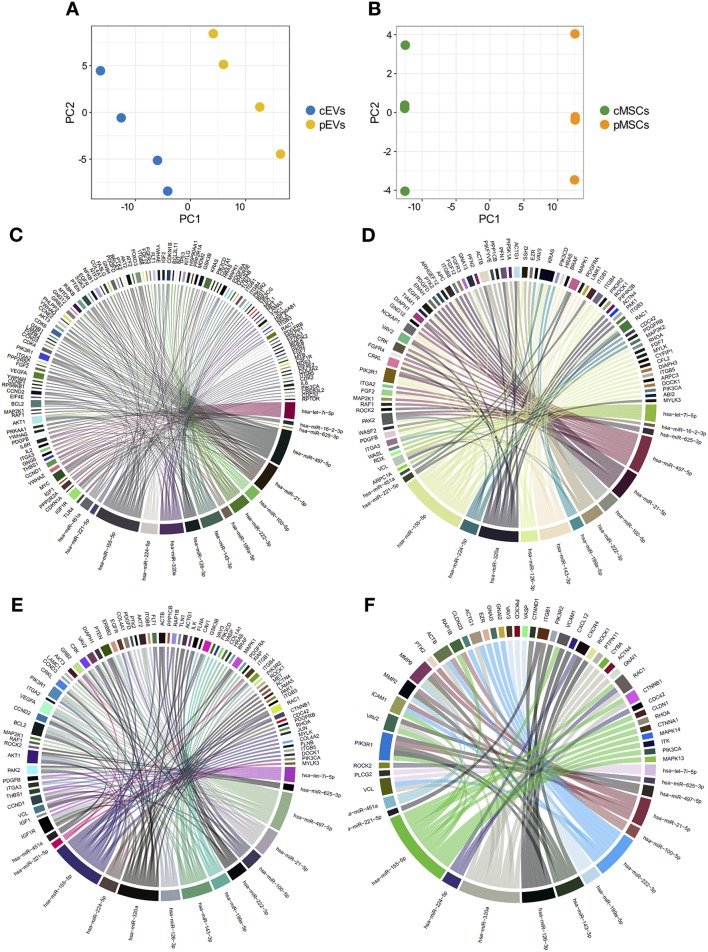
Combination of miRNA and proteomic profiles of MSCs and EVs. Score plot of the first two PCs calculated after the application of PCA to EVs (A) and MSCs (B). Chord diagrams representing proteins belonging to “PI3K-AKT signaling pathway” (C), “regulation of actin cytoskeleton” (D), “focal adhesion” (E), and “leukocyte trans-endothelial migration” (F) KEGG pathways targeted by miRNAs differentially expressed in pEVs.